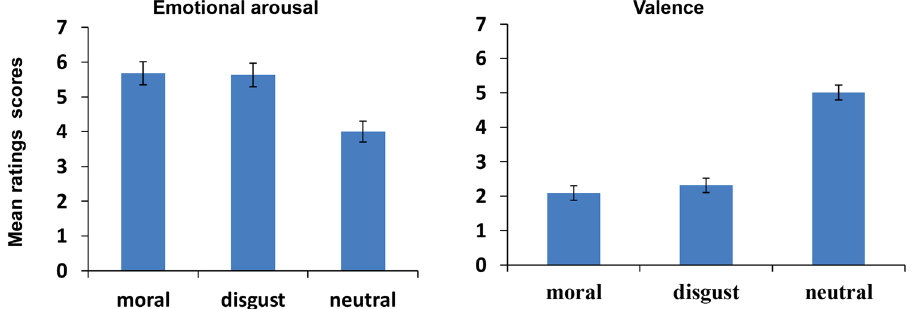
Figure 1. Self-reported rating Scores (M + / − SEM) of the emotional arousal and valence for the moral, disgust and neutral